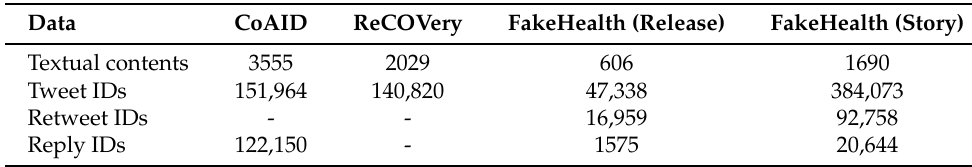
Table 1. Dimensionality of the original